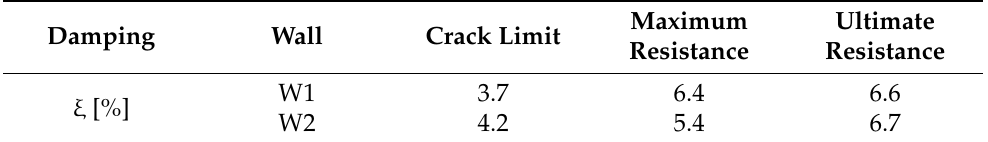
Table 5. Equivalent viscous damping for characteristic limit states of W1 and W2.